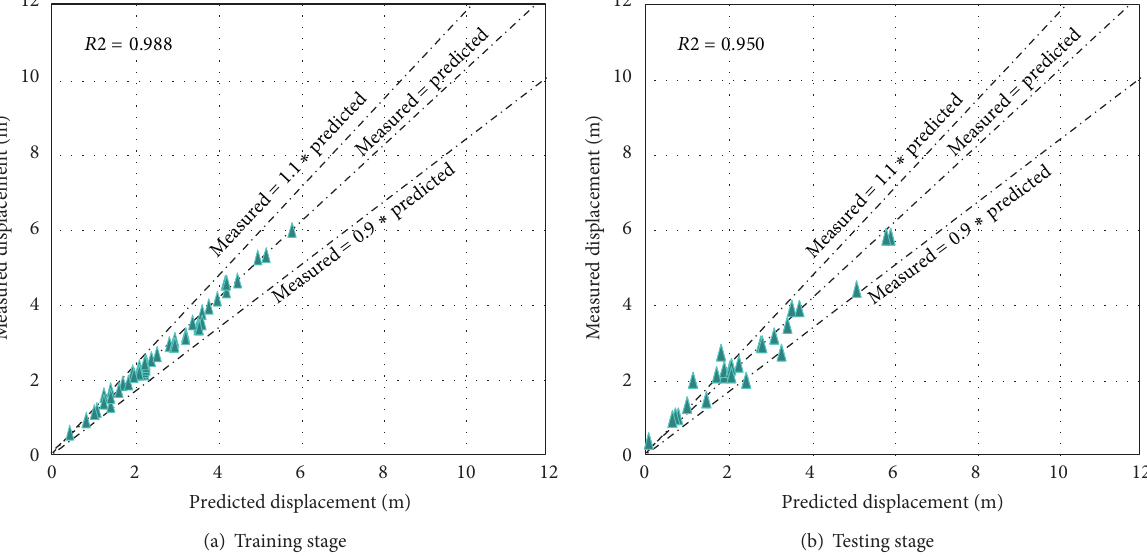
computed values with the unknown horizontal